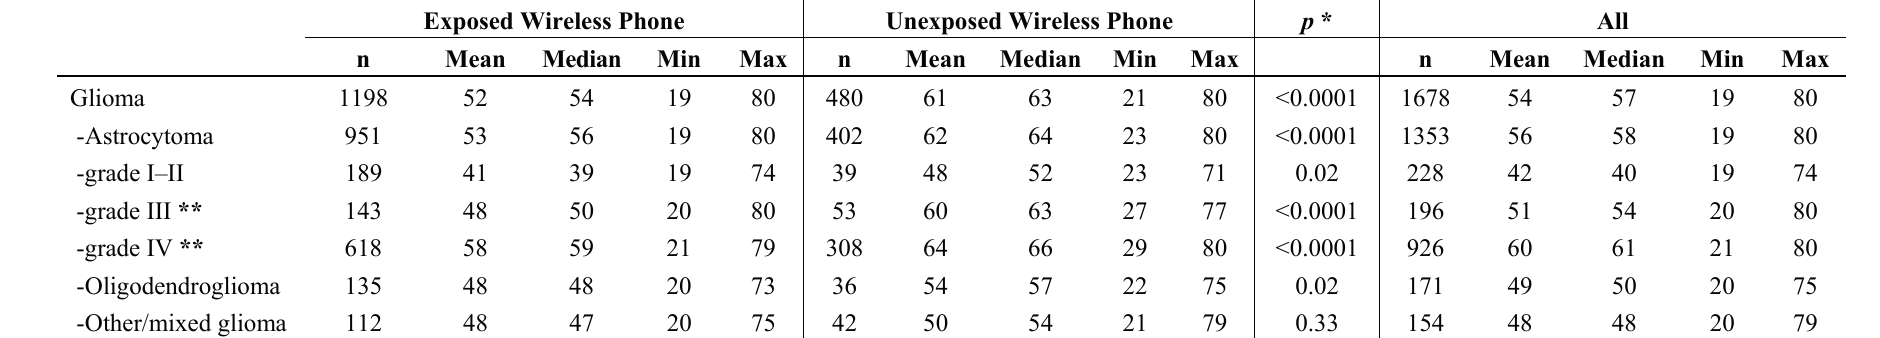
Table 1. Statistics of the age distribution for all cases and for exposed/unexposed to wireless phones. Exposed Wireless Phone Unexposed Wireless Phone